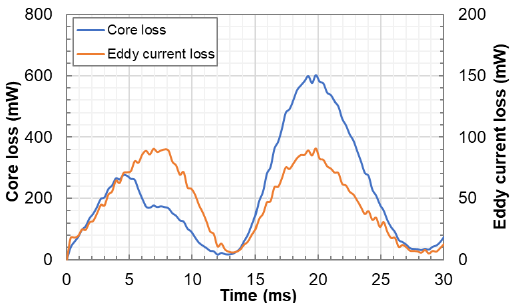
Figure 9. Core loss and additional eddy current loss of coils and magnets in one cycle from the FEA model with a stroke of 12 mm.